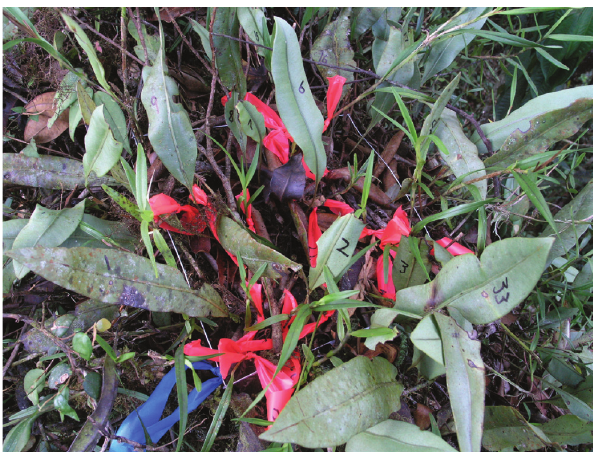
Figure S4. Control mat. A control epiphyte mat after being surveyed in 2005. This mat at 1800 m elevation included primarily Elaphoglossum and Schaphyglottis .